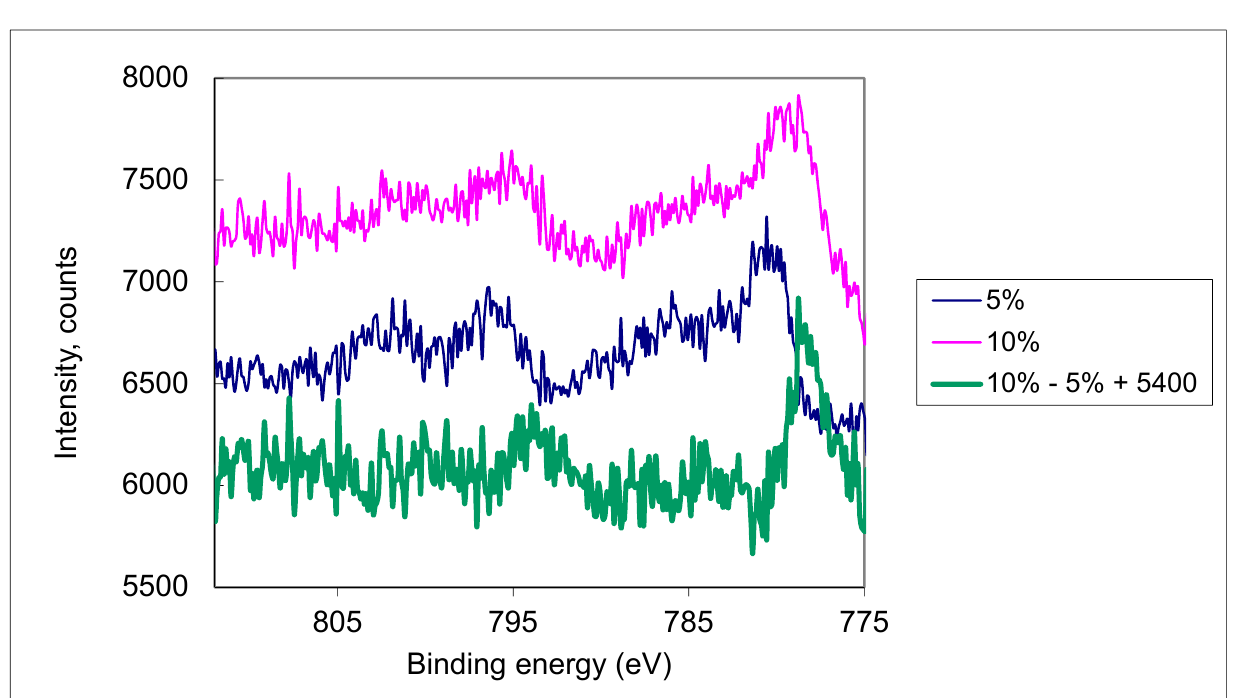
Figure 1. XPS spectra of the samples TiO 2 :0.05Co and TiO 2 :0.1Co.